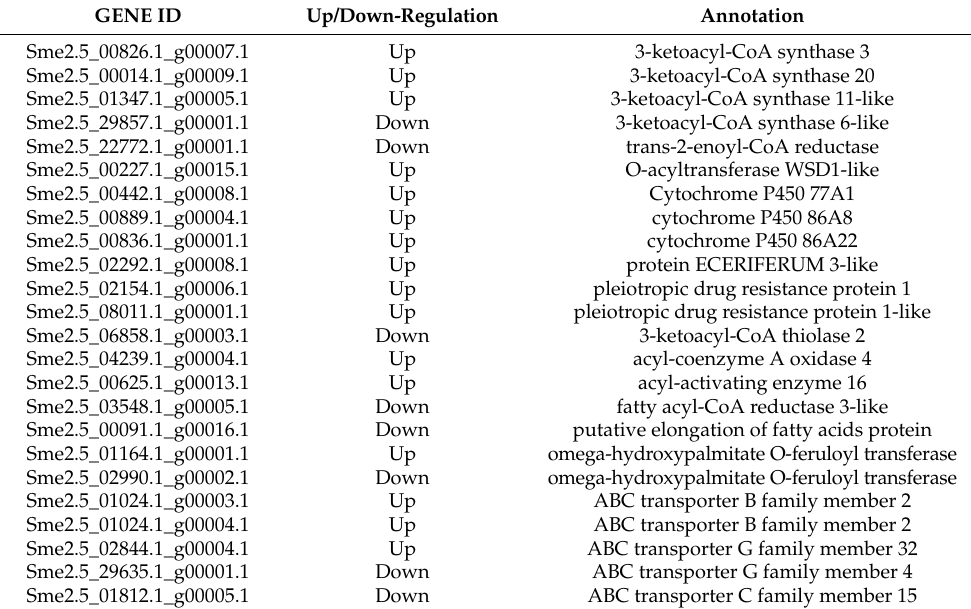
Table 3. The expression level and annotation of DEGs related to cutin and wax in groups 22 DAP vs. 14